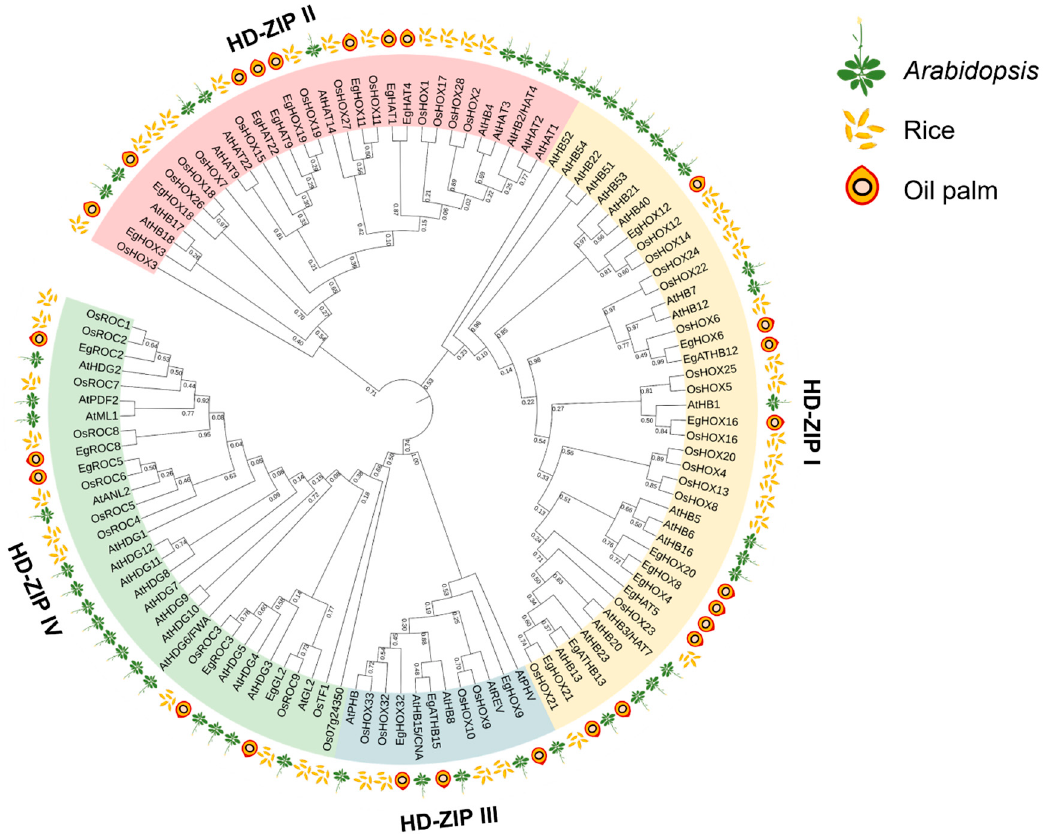
Figure 1. Phylogenetic analysis of HD-ZIP proteins in oil palm, Arabidopsis , and rice. The phylogenetic tree was constructed based on HD-ZIP protein sequences, which compose of 26 oil palm HD-ZIP proteins, 48 Arabidopsis HD-ZIP proteins, and 41 rice HD-ZIP proteins. Four HD-ZIP subfamilies are represented by different colors, including HD-ZIP I (yellow), HD-ZIP II (pink), HD-ZIP III (blue), and HD-ZIP IV (green).